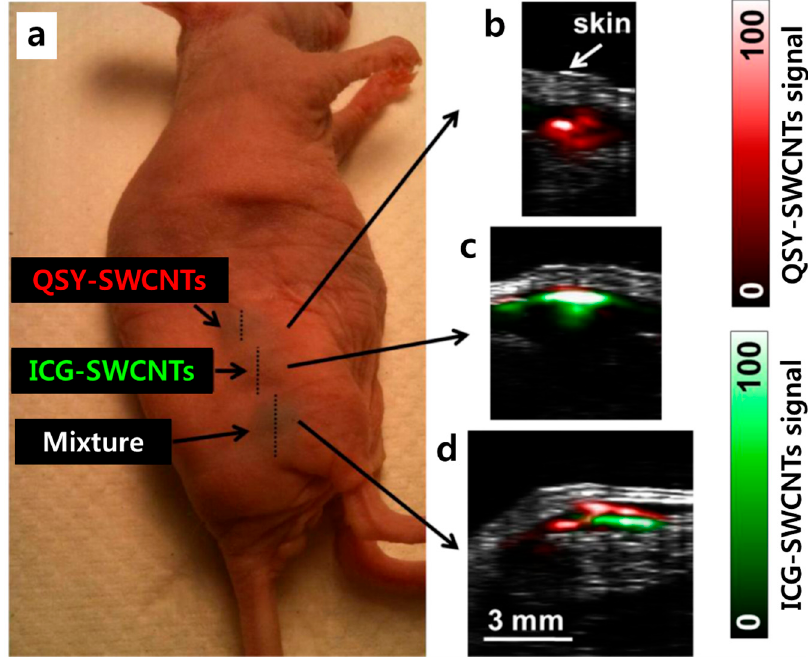
Figure 5. ( a ) A mouse was injected with 30 µ L of 50 nM QSY-SWCNTs (upper inclusion), 30 µ L of 50 nM ICG-SWCNTs (middle inclusion), and 30 µ L of an equal mixture of 50 nM of QSY-SWCNTs and ICG-SWCNTs (lower inclusion); ( b ) The unmixed photoacoustic vertical slice through the upper inclusion, showing only the QSY-SWCNTs signal (red); ( c ) The unmixed photoacoustic slice through the middle inclusion showing mostly the ICG-SWCNTs signal (green); ( d ) The unmixed photoacoustic slice through the lower inclusion, showing both the QSY-SWCNTs and ICG-SWCNTs signals spread throughout the inclusion area. The segregation between the QSY-SWCNTs and ICG-SWCNTs signals occurred because of some artifacts during the image reconstruction process due to the movement of the animal and heterogeneous penetration of light. Reprinted with permission from Reference [56]. Copyright (2016) American Chemical Society.